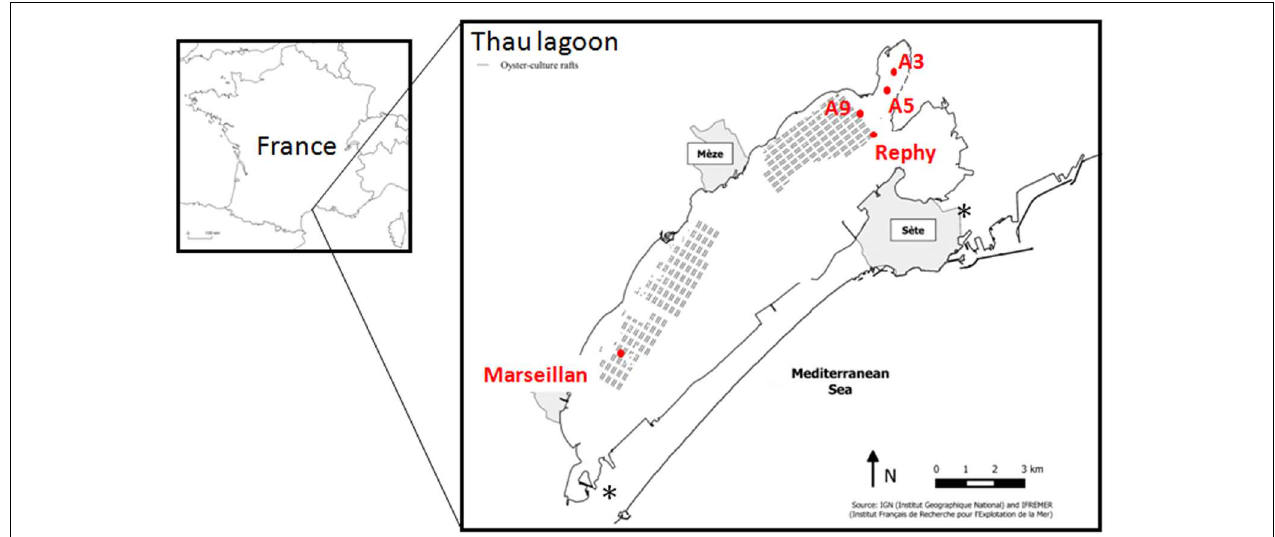
FIGURE 1 | Location and map of the Thau Lagoon. The sampling sites (red dots) are located inside (A9 and Rephy) and outside (A3 and A5) the oyster farms. The position of oyster-culture rafts within farms is indicated by gray blocks. The position of seawater channels is indicated by an ∗